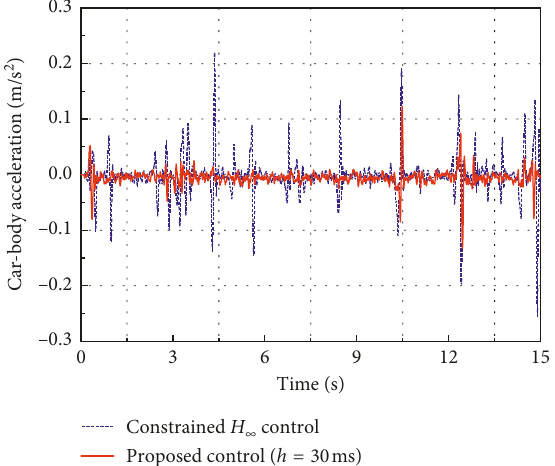
Figure 16: Hardware results of active control force under sinu- soidal wave signal.